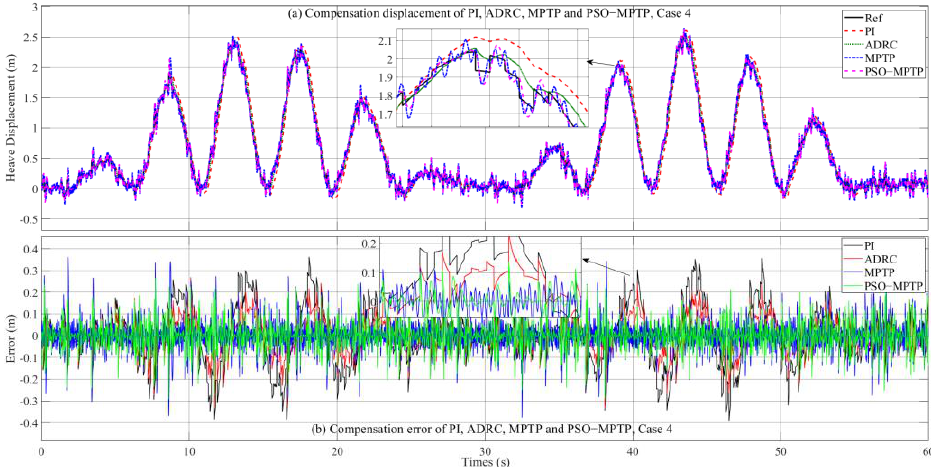
Figure 13. ( a ) Compensation displacement of PI, ADRC, MPTP, and PSO − MPTP, Case 4. ( b ) Com- pensation error of PI, ADRC, MPTP, and PSO − MPTP, Case 4.